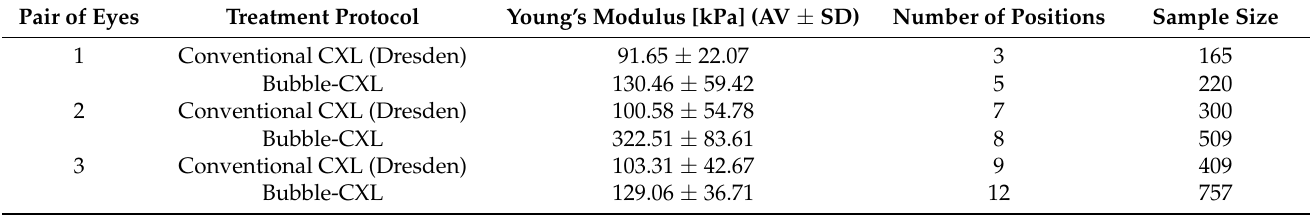
Table 1. Summary of Young’s moduli (average ± standard deviation) of corneas from three pairs of eyes treated either with conventional CXL or Bubble-CXL. The sample size describes the sum of force–distance curves recorded on various sample positions (number of positions) used for Young’s modulus